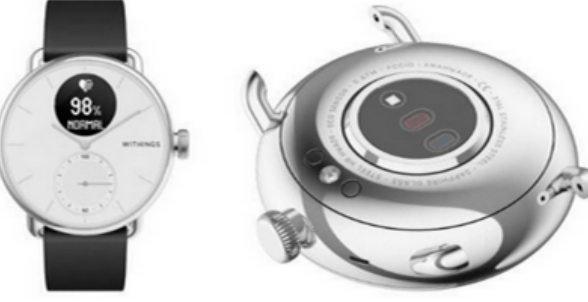
Figure 3. Front view (left) and back view (right) of the Withings